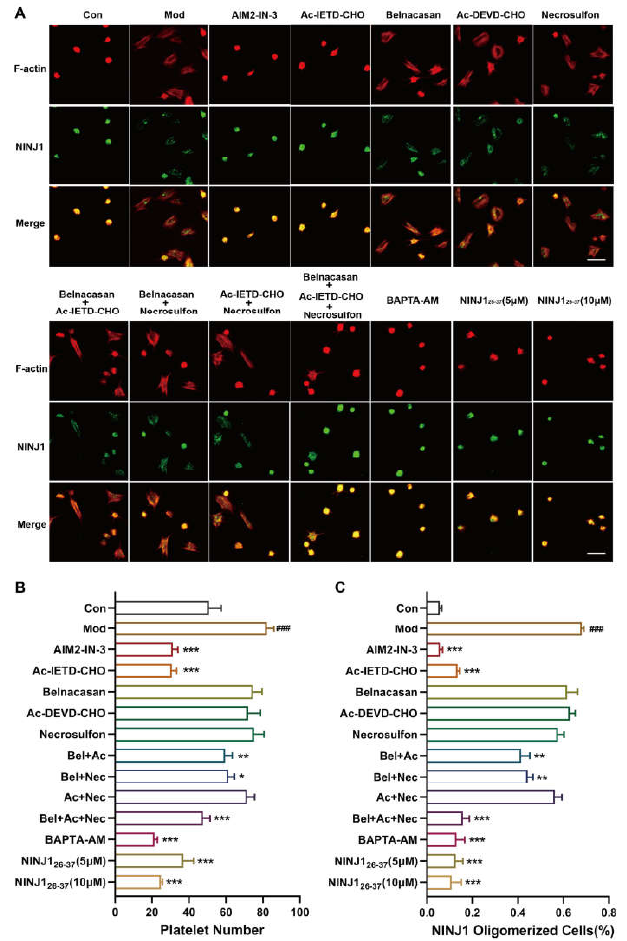
Figure 3. Oligomerization of NINJ1 in membrane-ruptured platelets is regulated by the PANoptosis pathway. ( A ) Washed platelets incubated with different inhibitors (AIM2-IN-3, Ac-IETD-CHO, Belnacasan, Ac-DEVD-CHO, Necrosulfon, BAPTA-AM, NINJ1 26–37 ) adhered to and spread on fibrinogen with thrombin (0.1 U/mL) for 1.5 h at 37 °C. Compared with the control group, the other groups were pretreated with thrombin (0.01 U/mL). Once fixed and stained, the platelets were observed with a fluorescence microscope. Scale bar represents 5 μm. ( B ) Number of adhesion and ( C ) oligomerization ratio of NINJ1 from five randomly selected fields of three different tests. Values are mean ± SEM, * p < 0.05, ** p < 0.01, *** p < 0.001 vs. resting platelets; ### p < 0.001 vs. activated platelets.